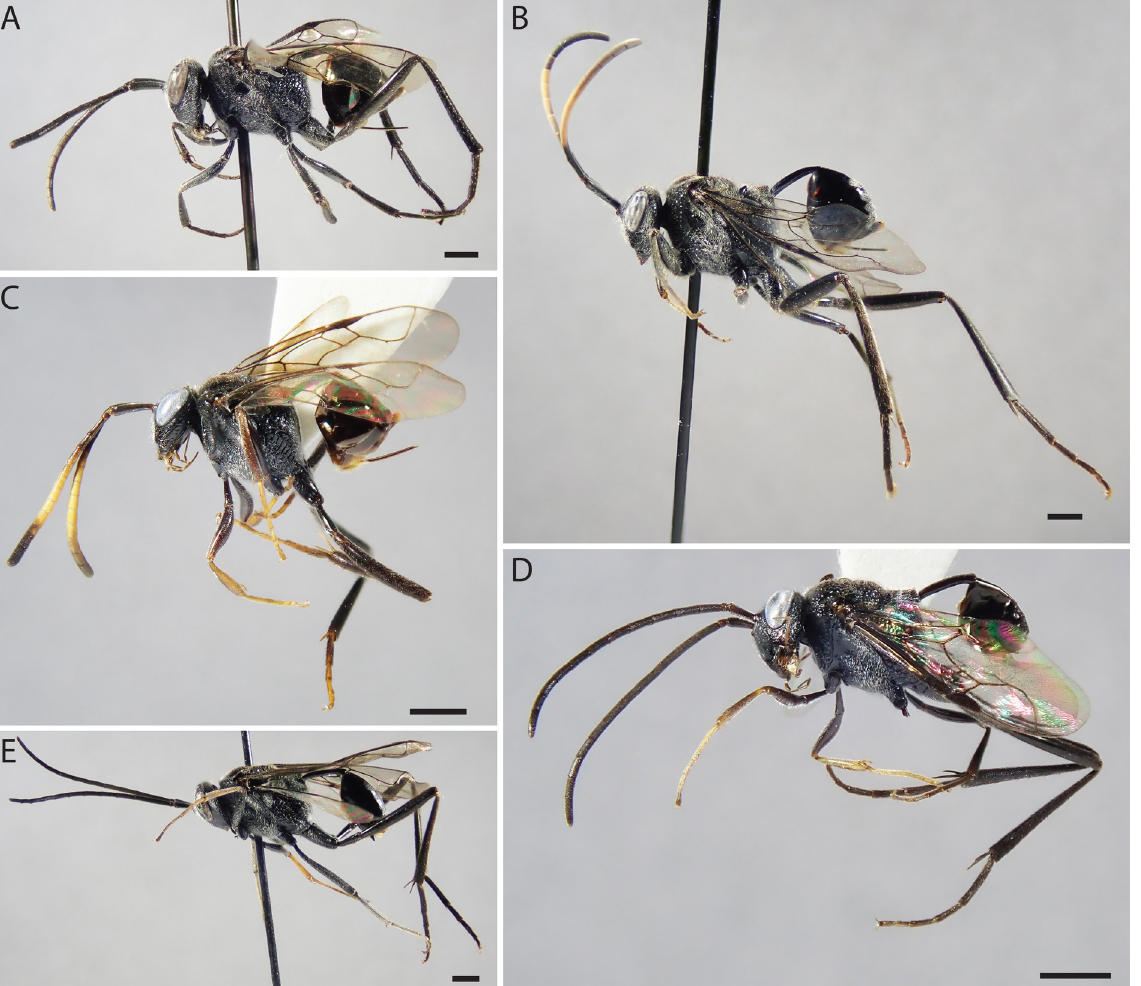
Fig. 6. Evaniidae (MNHN). A . Szepligetella deercreeki Deans & Mikó, 2013. B . Szepligetella irwini Deans & Mikó, 2013. C . Szepligetella levipetiolata (Turner, 1919). D . Male 1 (indet.) from Malaise trap n°KAT8-MAL4. E . Male 2 (indet.) from Malaise trap n°KAT8-MAL3. Scale bars =